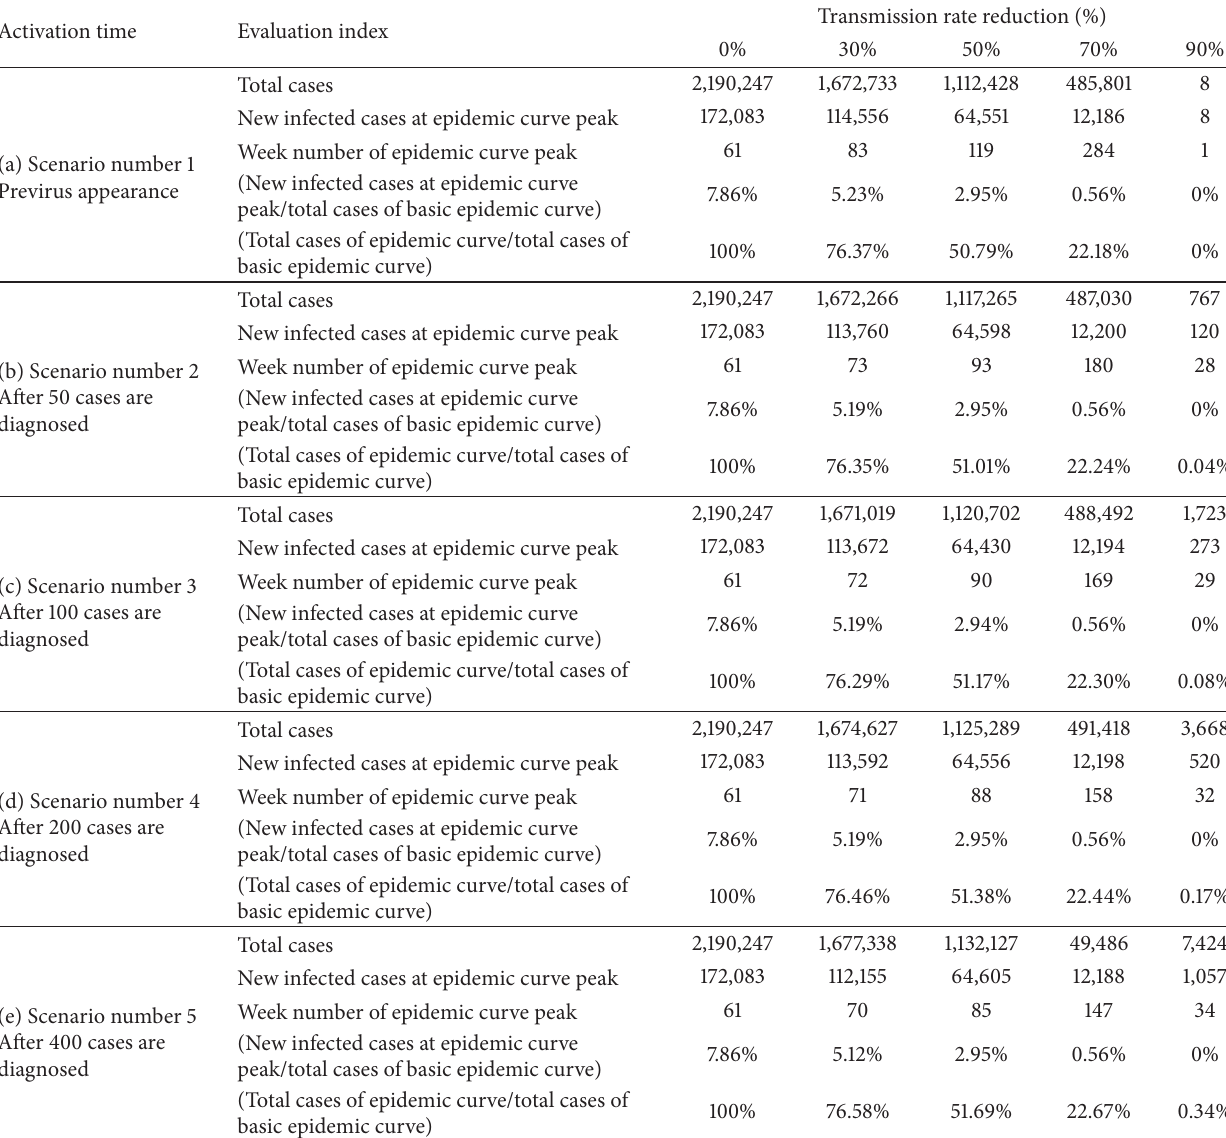
Table 3: Observation index values according to different policy activation scenarios during swine-origin H1N1 influenza A outbreak in